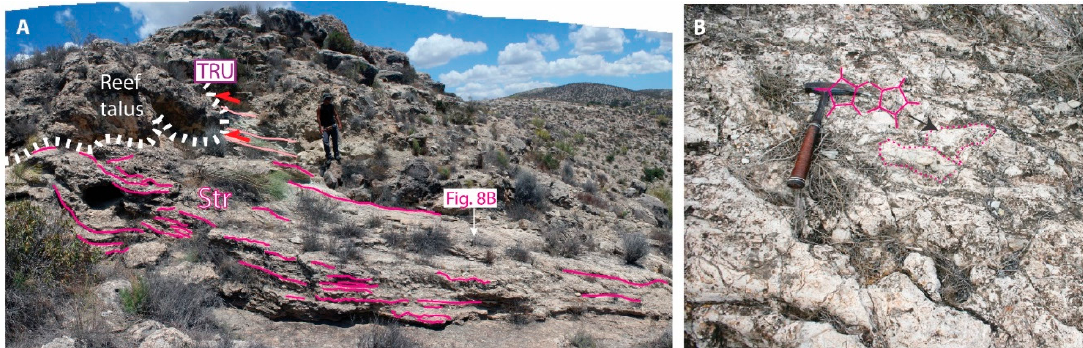
Figure 8. ( A ) Stratigraphic contact between the Reef Unit and the stromatolites of the Terminal Carbonate Complex (DS1); ( B ) close up-view of ( A ) showing desiccation cracks cutting the intertidal stromatolites. Locality of Moras.